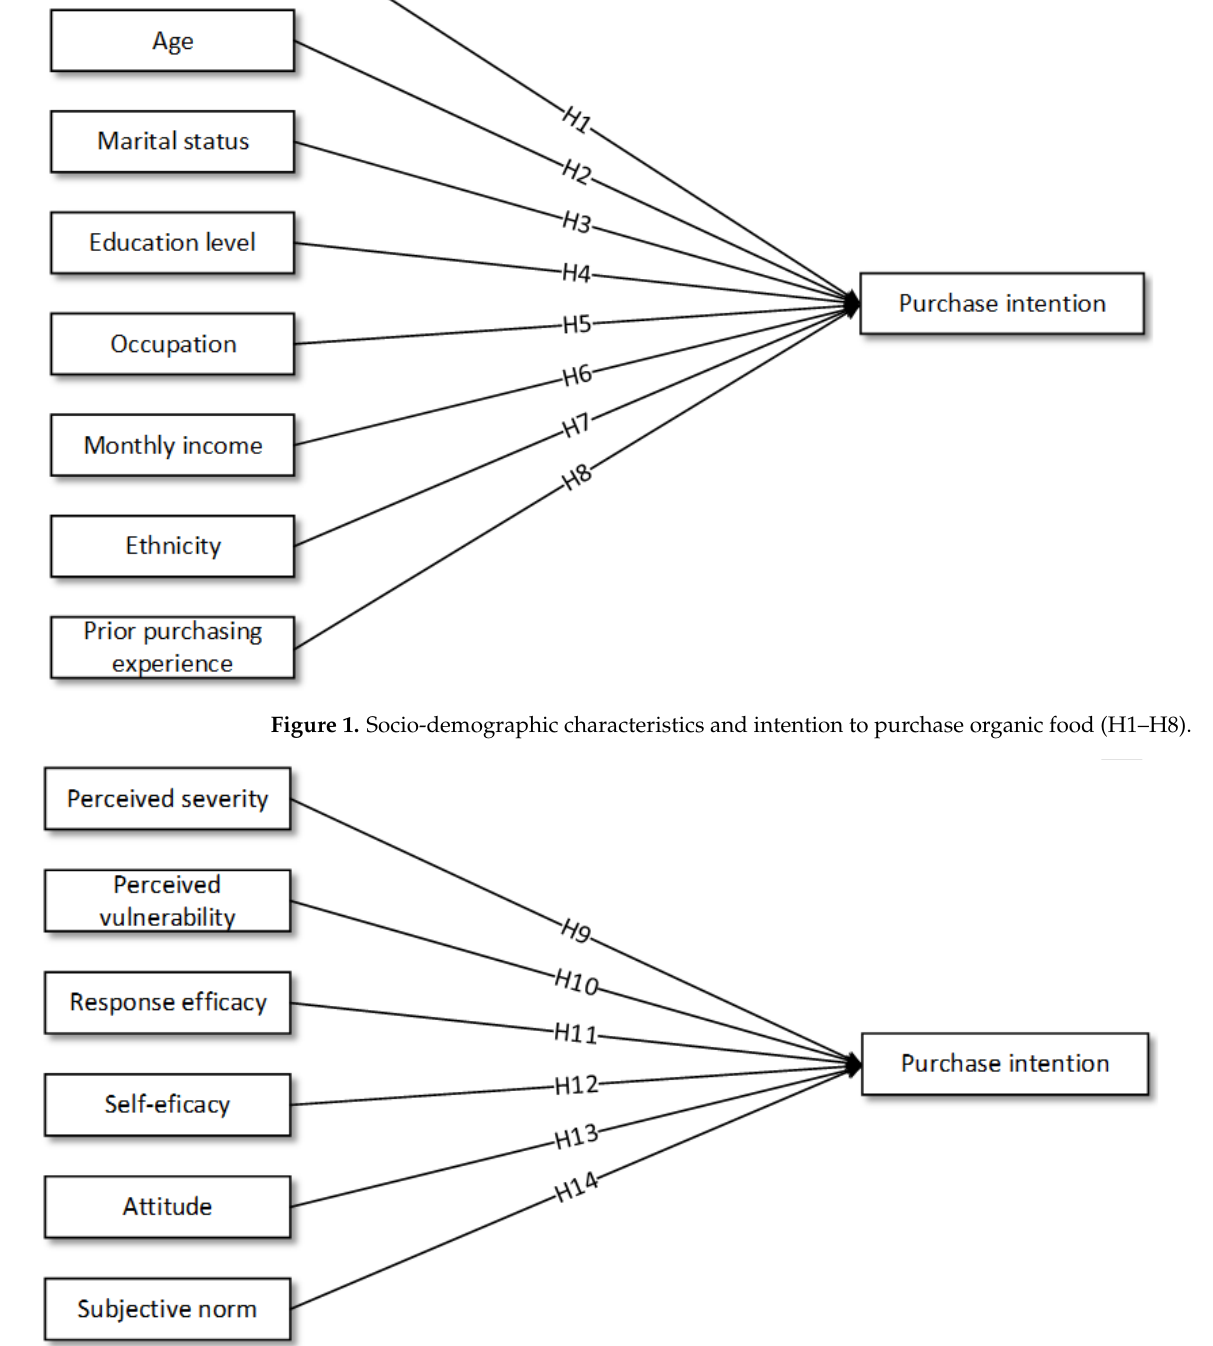
Figure 2. Multi-theoretical approach and purchase intention (H9 – H14).